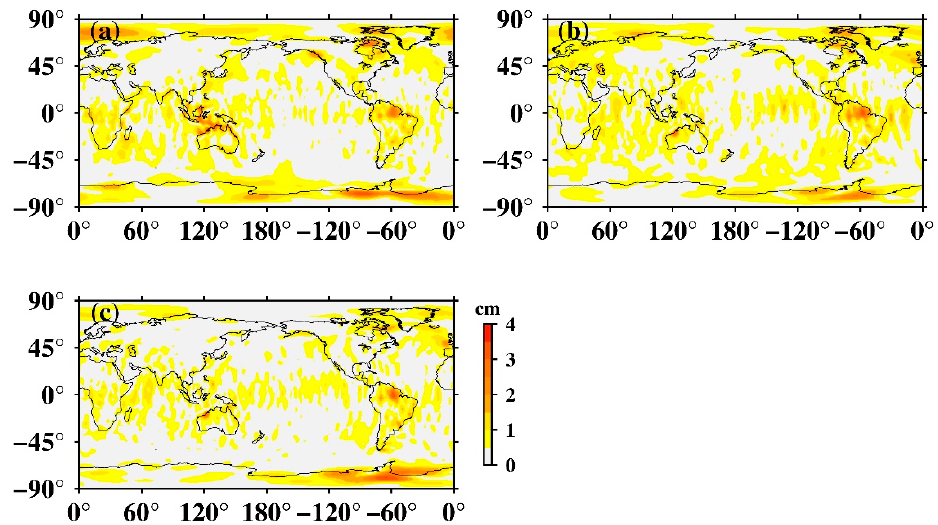
Figure 16. Global amplitude maps of S 2 tide aliasing after removal of the 161.0-day oscillation in low zonal coefficients. ( a ) Fitted from CSR SH data; ( b ) fitted from GFZ SH data; ( c ) fitted from JPL SH data.